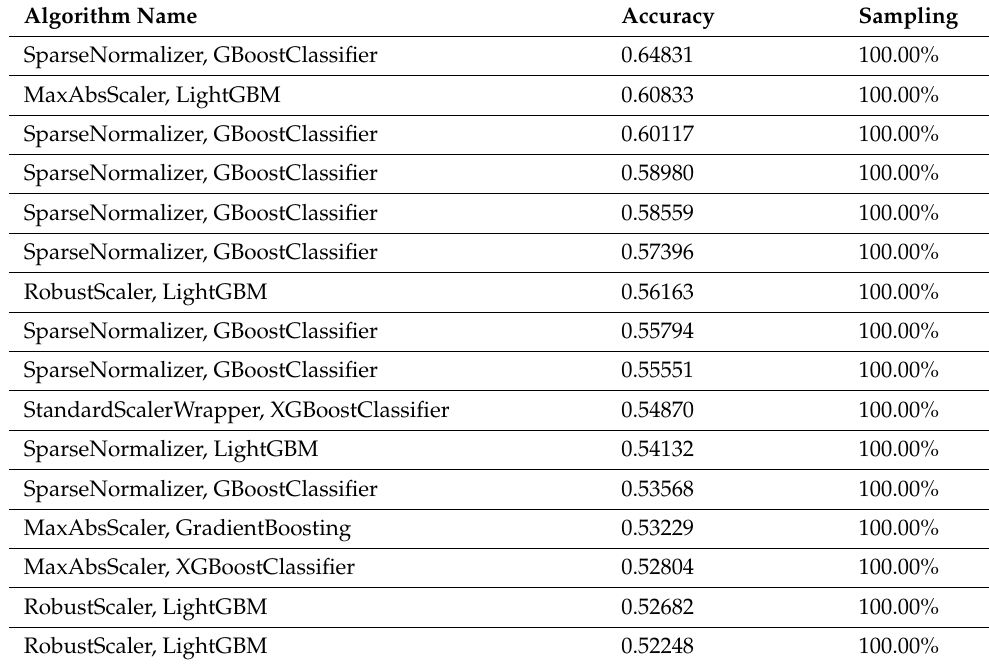
Table 3. Accuracy of models.